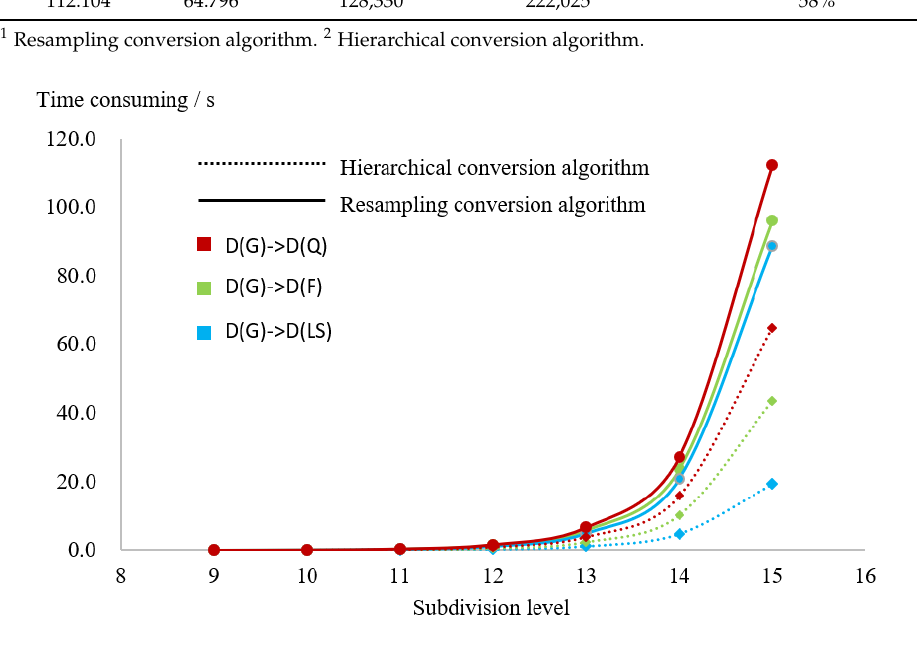
Figure 23. Comparison of efficiency between resampling algorithm and hierarchical conversion algorithm.